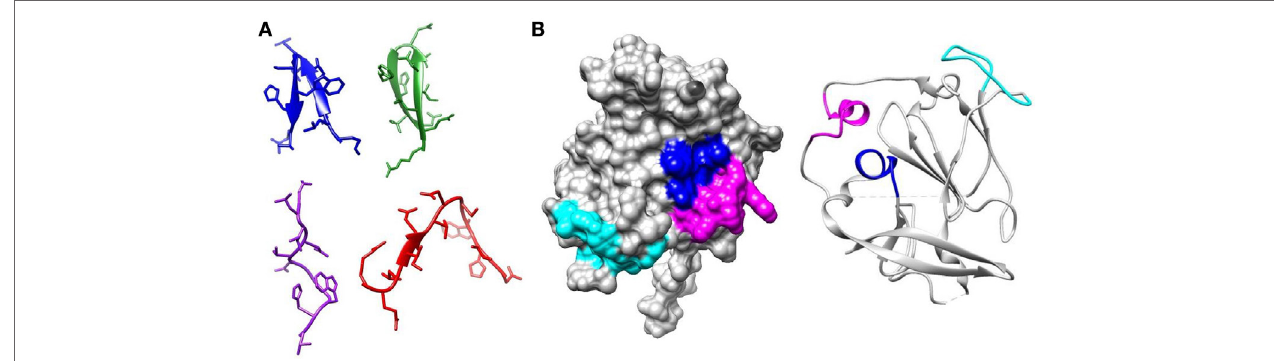
FigUre 1 | Regions of E2 targeted by broadly neutralizing antibodies. (a) Epitope 1 (412–423) is flexible. The structure of this region has been solved bound to several broadly neutralizing antibodies. In AP33 (blue) (PDB 4GAG) and HCV1 (green) (PDB 4DGV), this region forms a β -hairpin structure. In HC33.1 (red) (PDB 4XVJ), it has an intermediate structure between a β -hairpin and a coil and in 3/11 (purple) (PDB 4WHT), it has an extended conformation. (B) The core E2 structure (PDB 4MWF) with Epitope 2 (434–446) in magenta, Epitope 3 (525–535) in cyan, and Epitope 4 (611–617) in